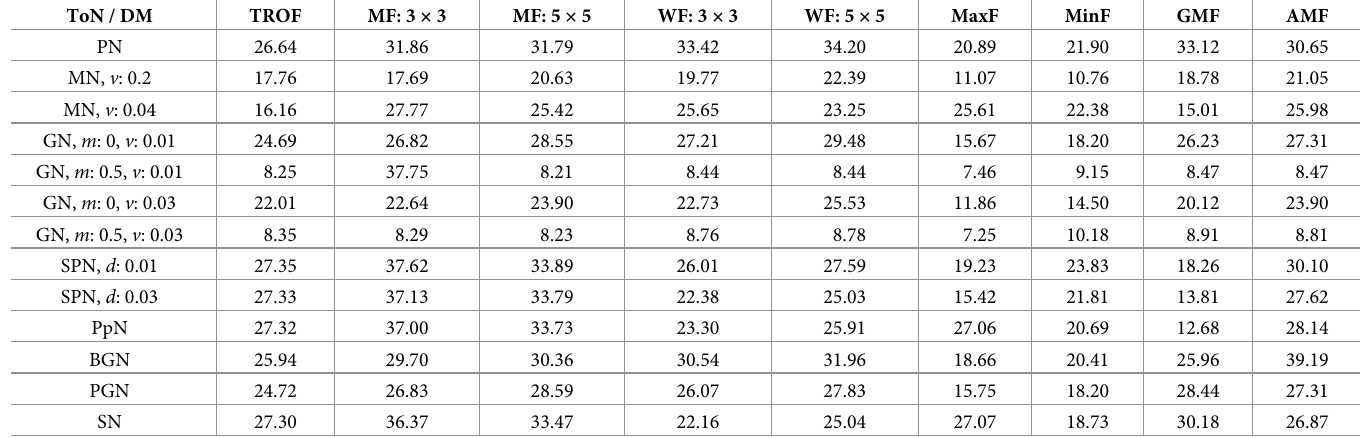
from images in EMDS-5 dataset. The seven operators are Canny, Laplace of Gaussian (LoG), Prewitt, Roberts, Sobel, Zero cross and CNN, and an example of the edge detection results is shown in Fig 4. For the edge detection of images, we choose two evaluation metrics, PSNR and SSIM, to evaluate the results of edge detection. We choose the edge detection result obtained by Sobel operator as the standard, and compare the results obtained by other edge detection methods with it and evaluate the results. A comparison of edge detection methods using EMDS-5 is shown in Table 6. From Table 6, we find that the PSNR evaluation index that the edge detection results obtained by the Prewitt operator are the most similar to the Sobel results. The SSIM evaluation index shows that the difference between the results of other operators and the results of Sobel operator is also very small. By comparison, we can see that EMDS-5 images can be used to detect and evaluate various edge detection methods.